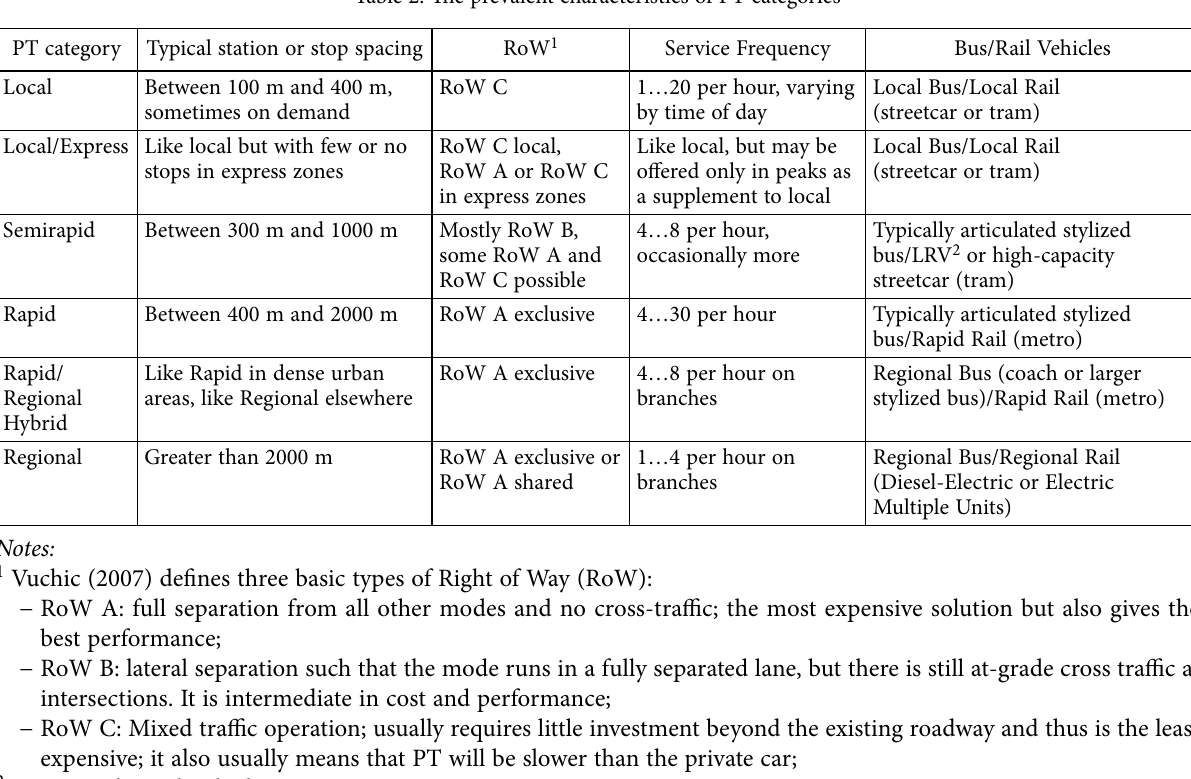
Table 2. The prevalent characteristics of PT categories